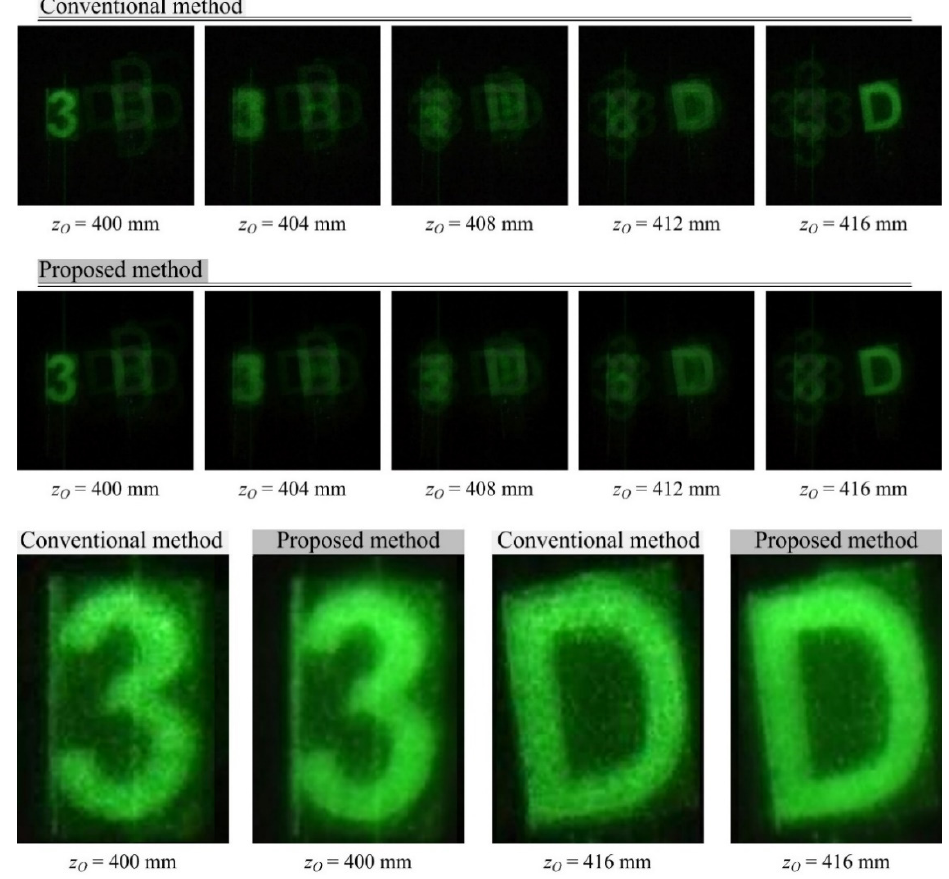
Figure 7. The 3-D computational reconstruction image by each of the conventional and proposed methods for the object in Figure 6a. The distance between the camera and the reconstruction plane is indicated at the bottom of each reconstructed image. At the bottom, zoomed images are displayed with normalized intensity.